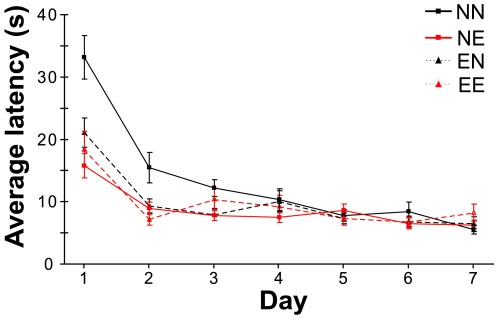
Enrichment limited to the pre-weaning period improves performance in the Morris water maze (MWM) to a level equivalent to life-long enrichment.Average MWM latencies across 7 training days of non-enriched mice (NN, solid black, n = 10), mice enriched from weaning (NE, solid red, n = 16), enriched from birth until weaning (EN, dashed black, n = 7) and enriched from birth into adulthood (EE, dashed red, n = 7). Mice receiving enrichment performed significantly better across the 7 training days relative to non-enriched mice (Mixed model ANOVA, F(3, 36) = 8.48, p<0.001; see text).